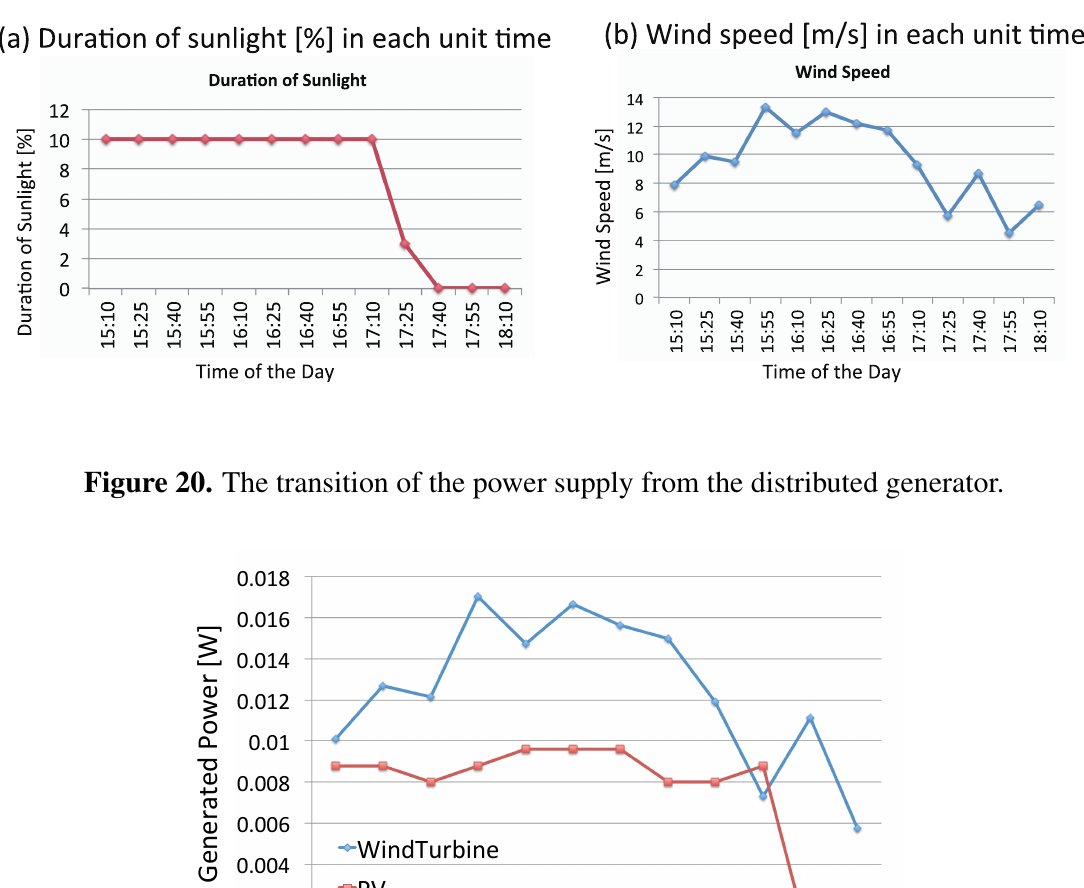
Figure 19. Weather data of Sendai, Japan, on 13 October 2013 (a sunny and windy day).